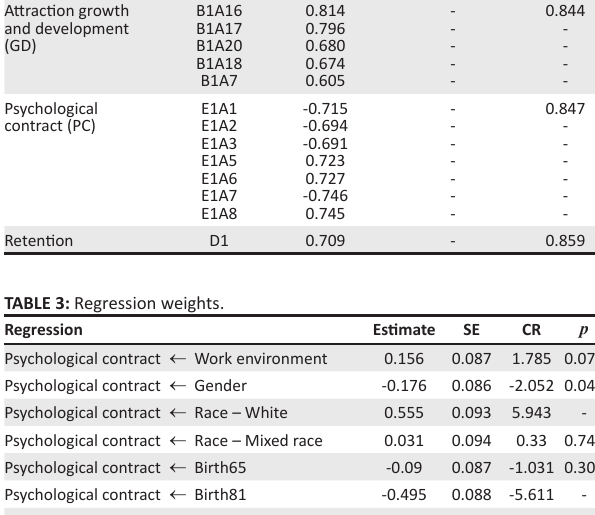
Standardised Average variance indicator loading extracted